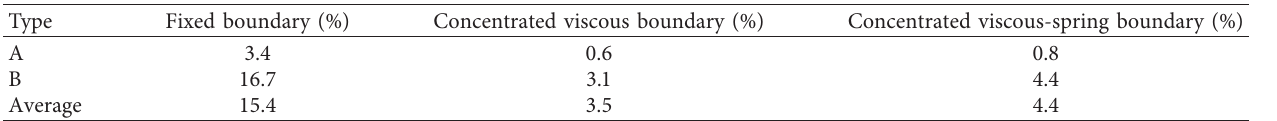
Table 5: Factors of accuracy improvement of